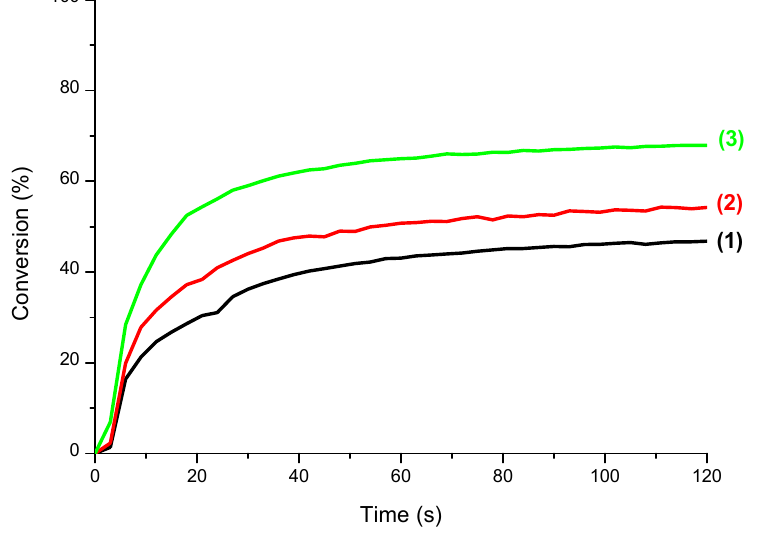
Figure 8. Photopolymerization profiles (methacrylate function conversion vs. irradiation time) for Prime&Bond Active ® resin (under air; 13 µ m thin films) upon exposure to the LED@477 nm (I 0 = 300 mW · cm − 2 ) using di ff erent photoinitiating systems. (1) CQ / 4-(dimethylamino)benzonitrile (DMABN) (1.5 / 0.6 % w / w ); (2) CQ / DMABN / S5 (1.5 / 0.6 / 0.75 % w / w ); (3) CQ / DMABN / S6 (1.5 / 0.6 / 0.75 % w / w ). The irradiation starts for t = 5